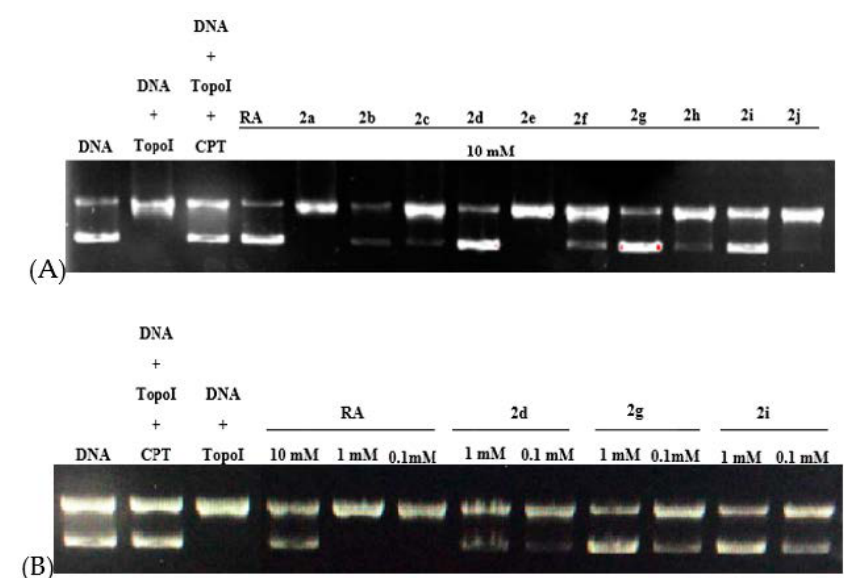
Figure 5. DNA topoisomerase I (Topo I) inhibitory activity of ( A ) CPT, RA, and all target compounds ( 2a–2j ) at 10 mM; ( B ) Compounds 2d , 2g , and 2i in different concentrations using CPT (0.1 mM) as a positive control.